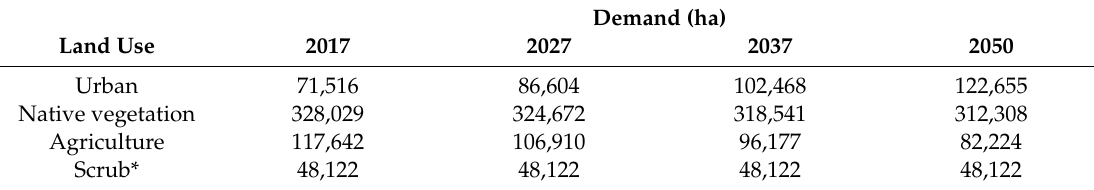
Table 6. Estimated land use demands